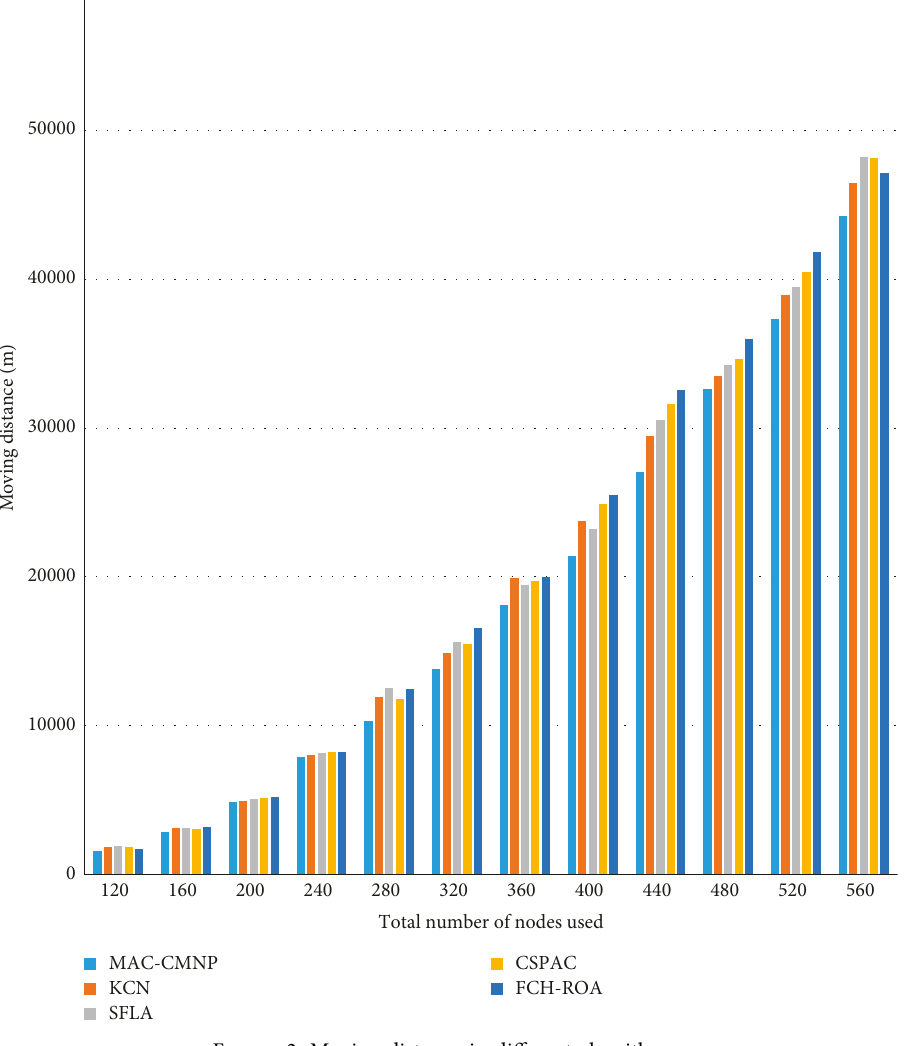
Figure 2: Moving distance in different